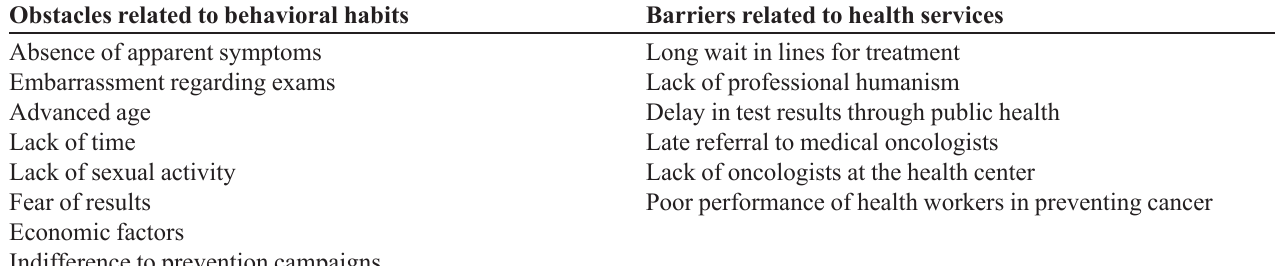
TABLE I - Barriers to cancer prevention in women Obstacles related to behavioral